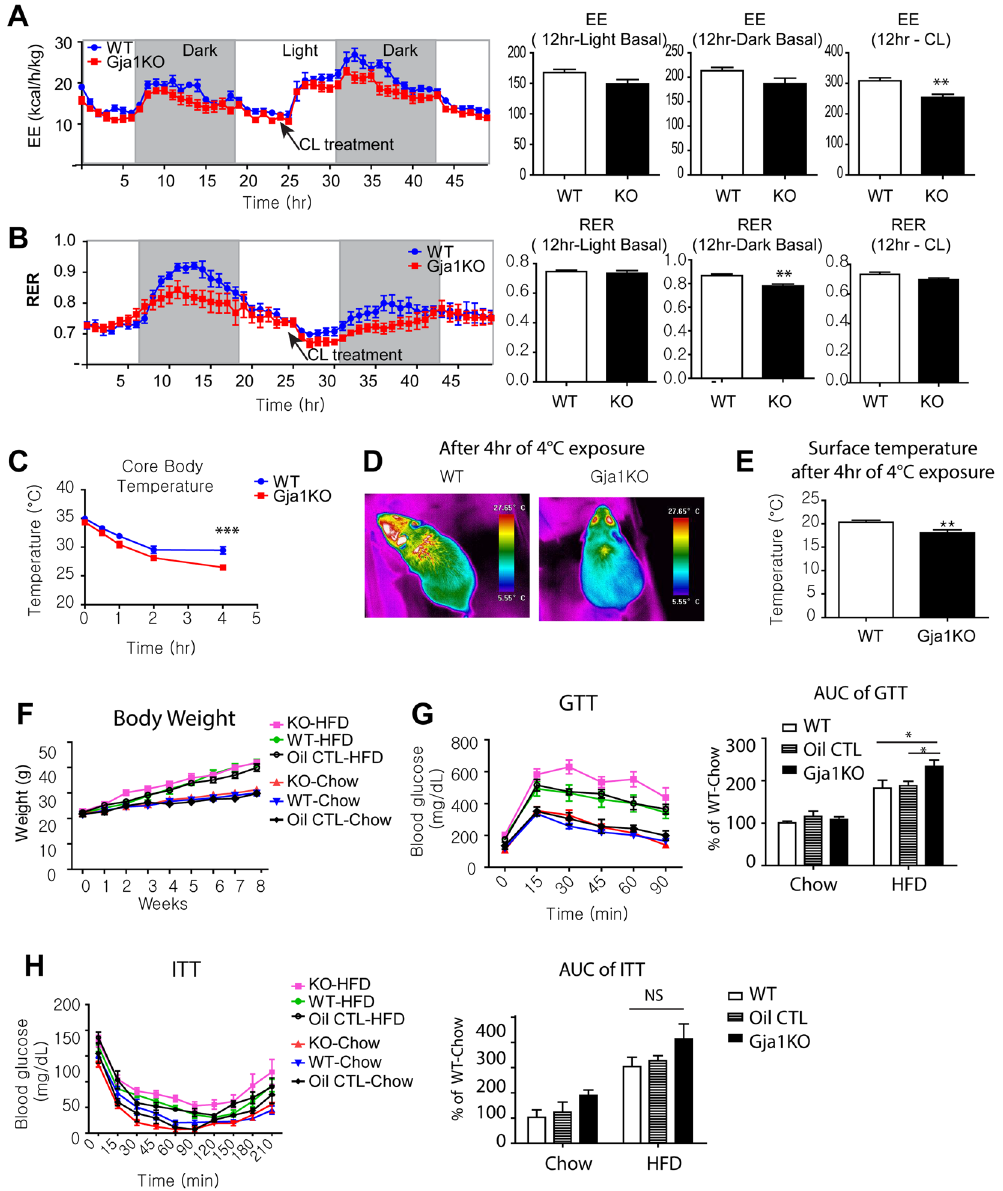
Figure 6. Adipose specific Gja1 KO manifested reduction in CL-induced energy expenditure, cold intolerance and insulin resistance after a high fat diet challenge. ( A,B ) Indirect calorimetry analysis. Energy expenditure (EE) ( A ) and energy exchange ratio (RER) ( B ) are shown. Arrows indicate the time of CL injection. mean ± SEM, n = 6 per group). ( C–E ) Analysis of body temperature: core body temperature ( C ), thermal images ( D ), surface temperature of region of iBAT ( E ) in WT and Gja1 adipoq KO mice exposed at 22 °C and 4 °C for up to 4 hr (n = 4 per group). ( F–H ) Measurement of body weight ( F ), glucose tolerance test (GTT) ( G ), and insulin tolerance test (ITT) ( H ) in WT (tamoxifen-treated WT/ Gja fl/fl ), Oil-CTL (oil-treated aCre/ Gja fl/fl ) and Gja1 adipoq KO (tamoxifen-treated aCre/ Gja fl/fl ) mice fed with chow or high fat diet (HFD) for 8 weeks (n = 6 per group). Two-way ANOVA revealed significant main effects of genotype (GTT: p = 0.029, ITT: p = 0.047) and diet (GTT: p = 0.001, ITT: p = 0.0003) on area under the curve of GTT and ITT plots. Significant differences between WT and Gja1 adipoq KO were determined by post-hoc pairwise comparison with Bonferroni correction (mean ± SEM; * p < 0.05, NS =